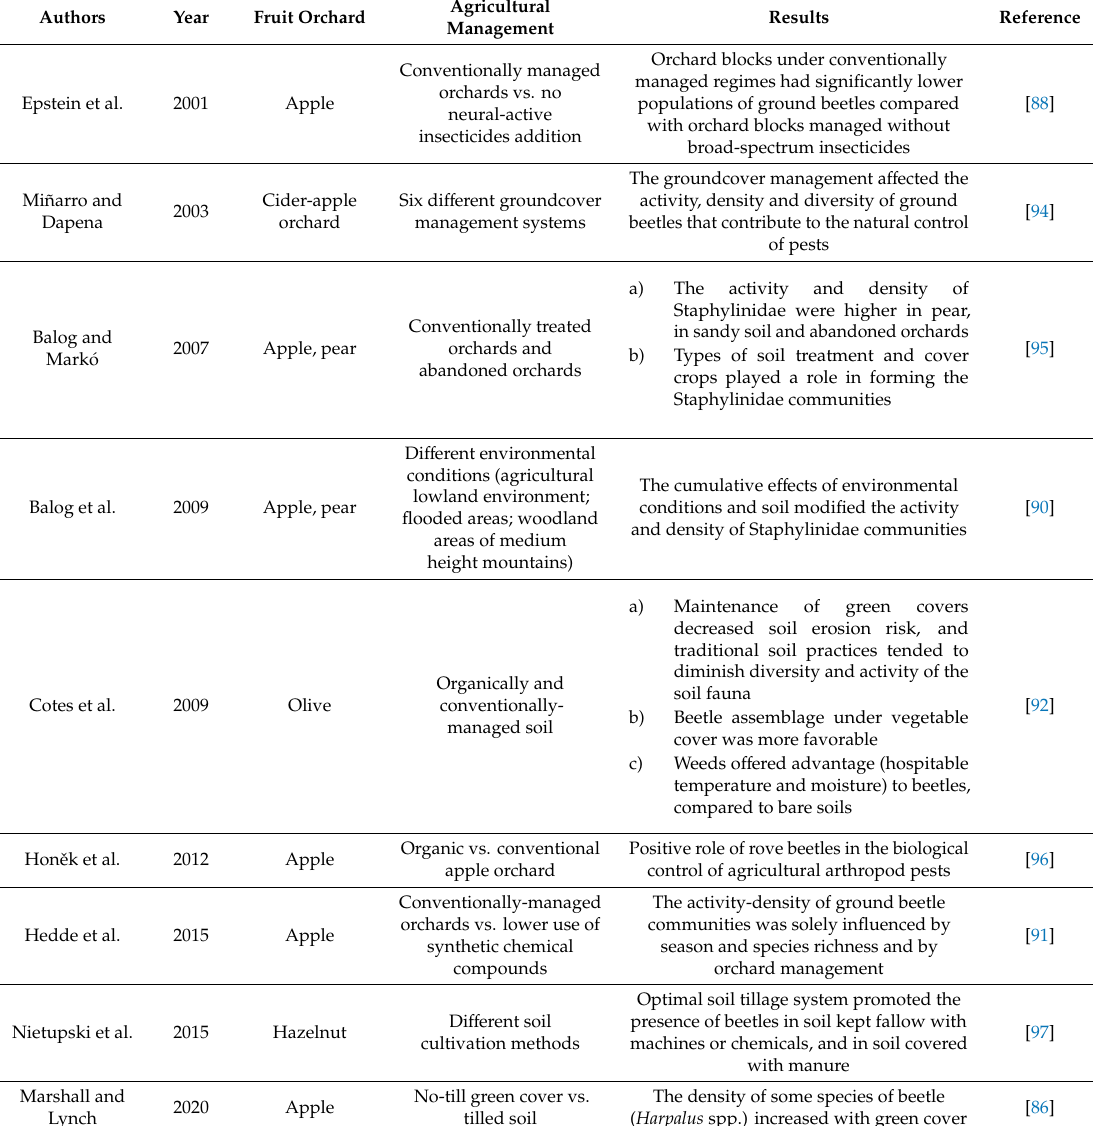
Table 4. E ff ects of di ff erential agricultural management on beetle dynamics in orchard